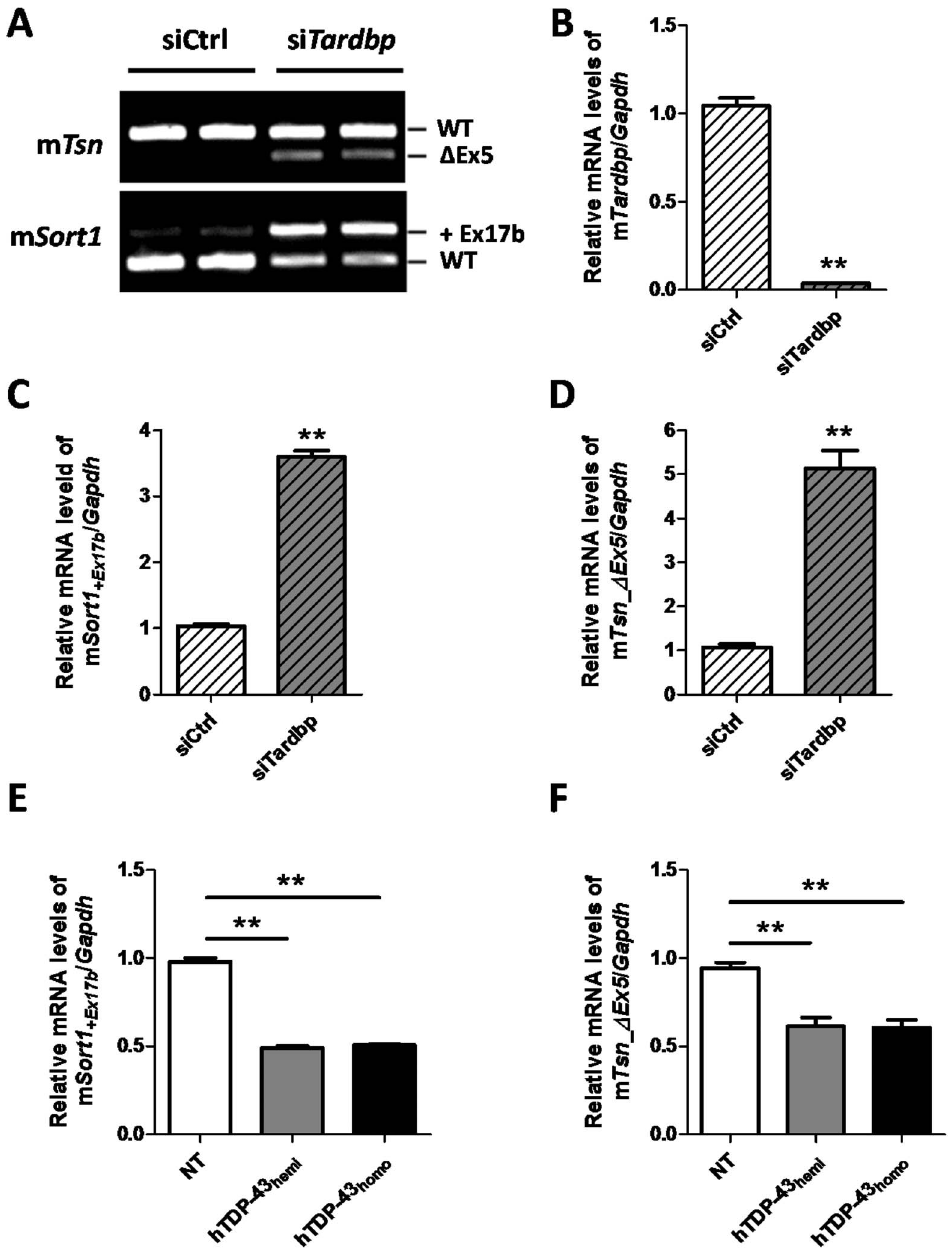
Figure 2. Expression of hTDP-43 rescues the abnormal splicing variants induced by mTdp-43 downregulation in human TDP-43 transgenic mice. ( A–D ) Knockdown of mTdp-43 induces abnormal splicing of TDP-43 RNA targets mouse sortilin 1 ( Sort1 ) and translin ( Tsn ) in N2a cells. ( A ) Knockdown of mTdp-43 in N2a cell line using small inference RNA (siRNA) leads to generation of abnormal splicing variants mSort1 + Ex17b and mTsn_ D Ex5 , indicating loss of mTdp-43 function. ( B–D ) Quantitative PCR (q-PCR) is used to quantify the mRNA levels of mTdp-43, mSort1 + Ex17b and mTsn_ D Ex5 . The levels of mSort1 + Ex17b and mTsn are significantly increased when Tdp-43 is depleted. ( E–F ) The mRNA levels of mSort1 + Ex17b ( E ) and mTsn_ D Ex5 ( F ) are not increased in hTDP-43 hemizygous and homozygous mice brain. In contrast, the levels of these two abnormal splicing variants are reduced dramatically in hTDP-43 transgenic mice. Data shown are the means 6 SEM of 5 mice per group; **p , 0.001, as assessed by one- way ANOVA with Tukey’s posthoc analysis. into plaques or of hyperphosphorylated tau into neurofibrillary evaluate potential therapeutic strategies for translational research. For instance, mutations in genes encoding amyloid precursor tangles [25,26]. Moreover, mutations in the SOD1 gene have also protein ( APP ), presenilins ( PSEN1 and PSEN2 ) or microtubule been used to generate transgenic mouse models, which develop the associated protein tau ( MAPT ) have been overexpressed in animals progressive loss of motor neurons, muscle weakness and atrophy, and eventual death similar to the pathological phenotypes in ALS to make Alzheimer’s disease (AD) mouse models, which are characterized by the production and accumulation of amyloid- b [27].